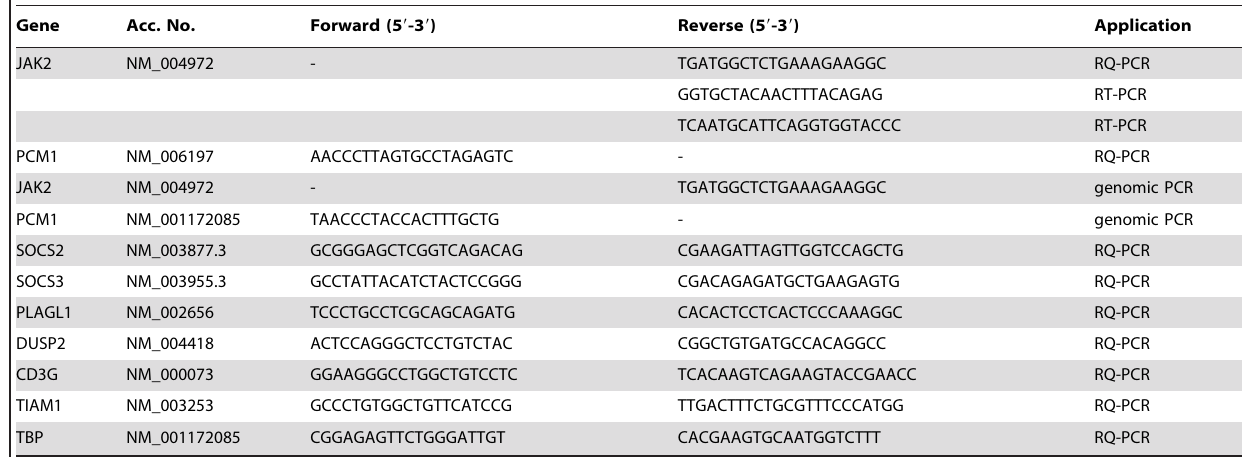
Table 1. Oligonucleotides.